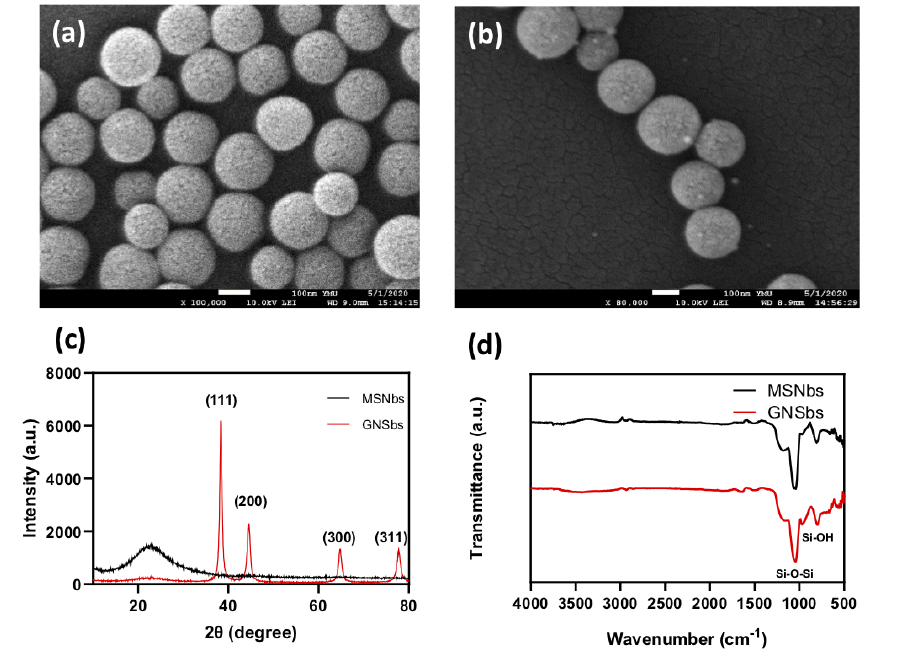
Figure 2. Physical analysis of gold nano-sesame-beads (GNSbs). The scanning electron microscopy analysis of ( a ) the mesoporous silica nanobeads (MSNbs) and ( b ) the gold nano-seasame-beads (GNSbs). ( c ) Typical X-ray diffraction ( XRD ) pattern and ( d ) the FTIR spectra of MSNbs and GNSbs.